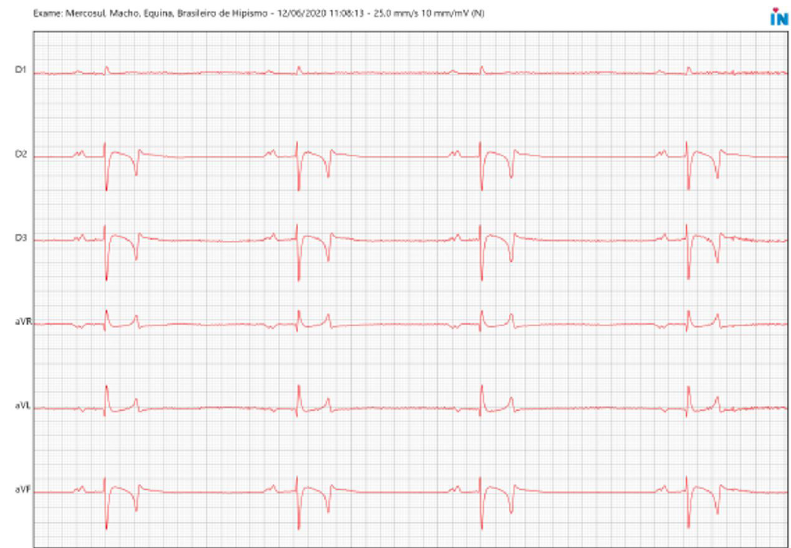
Figure 6. Electrocardiographic tracing performed with the animal at